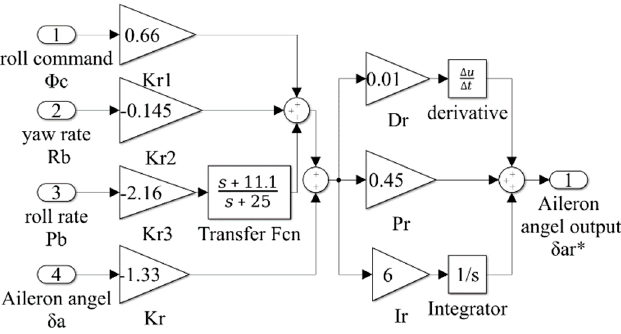
Figure 2. Simulink model of the roll control law of the primary flight computer (PFC).